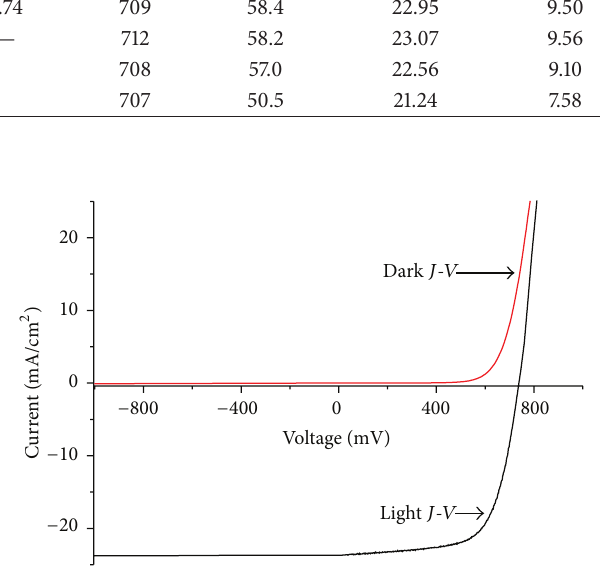
Figure 5: Dark and light J-V curves for a CdS/CdTe/Cu 1.4 Te solar